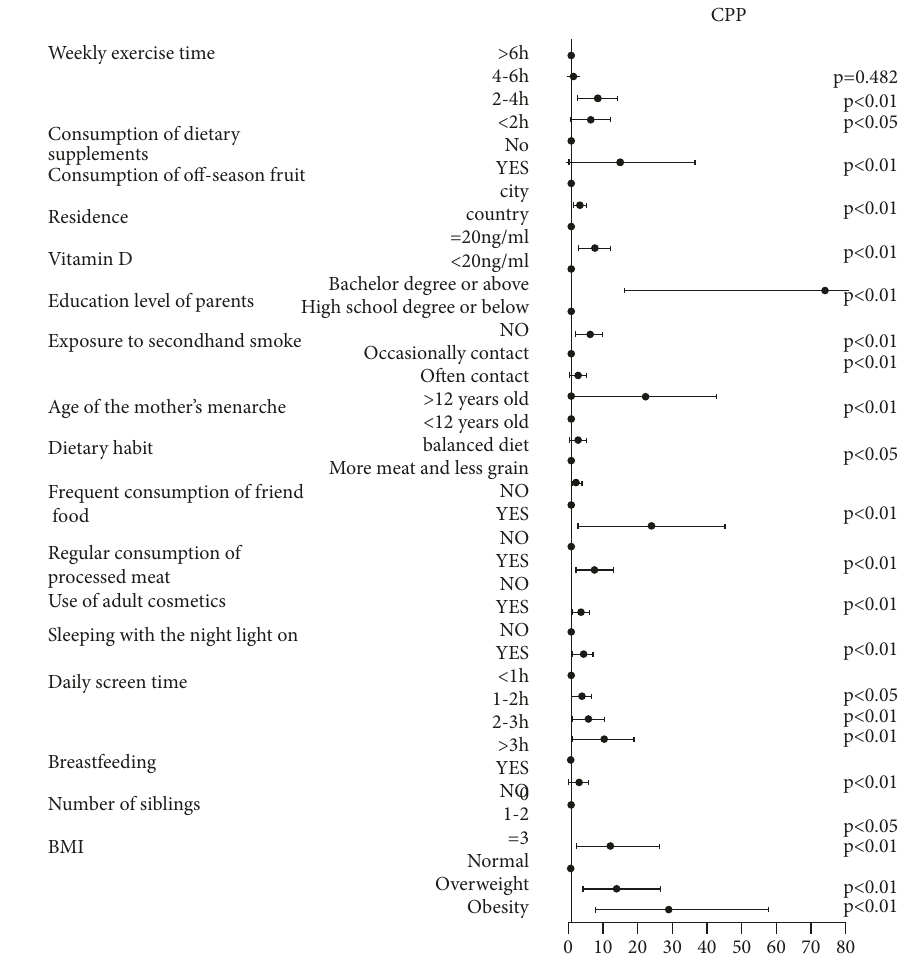
Figure 3: Logistic regression analysis of the risk factors for CPP. Multivariate odds ratios and 95% confidence intervals from unconditional logistic regression models are used in the analysis. CPP, central precocious